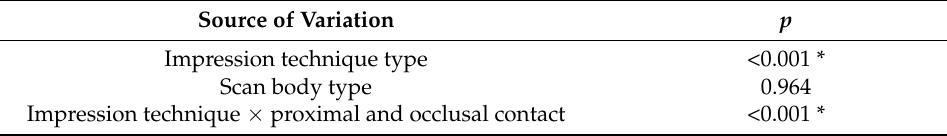
Table 2. Results of factorial ANOVA of